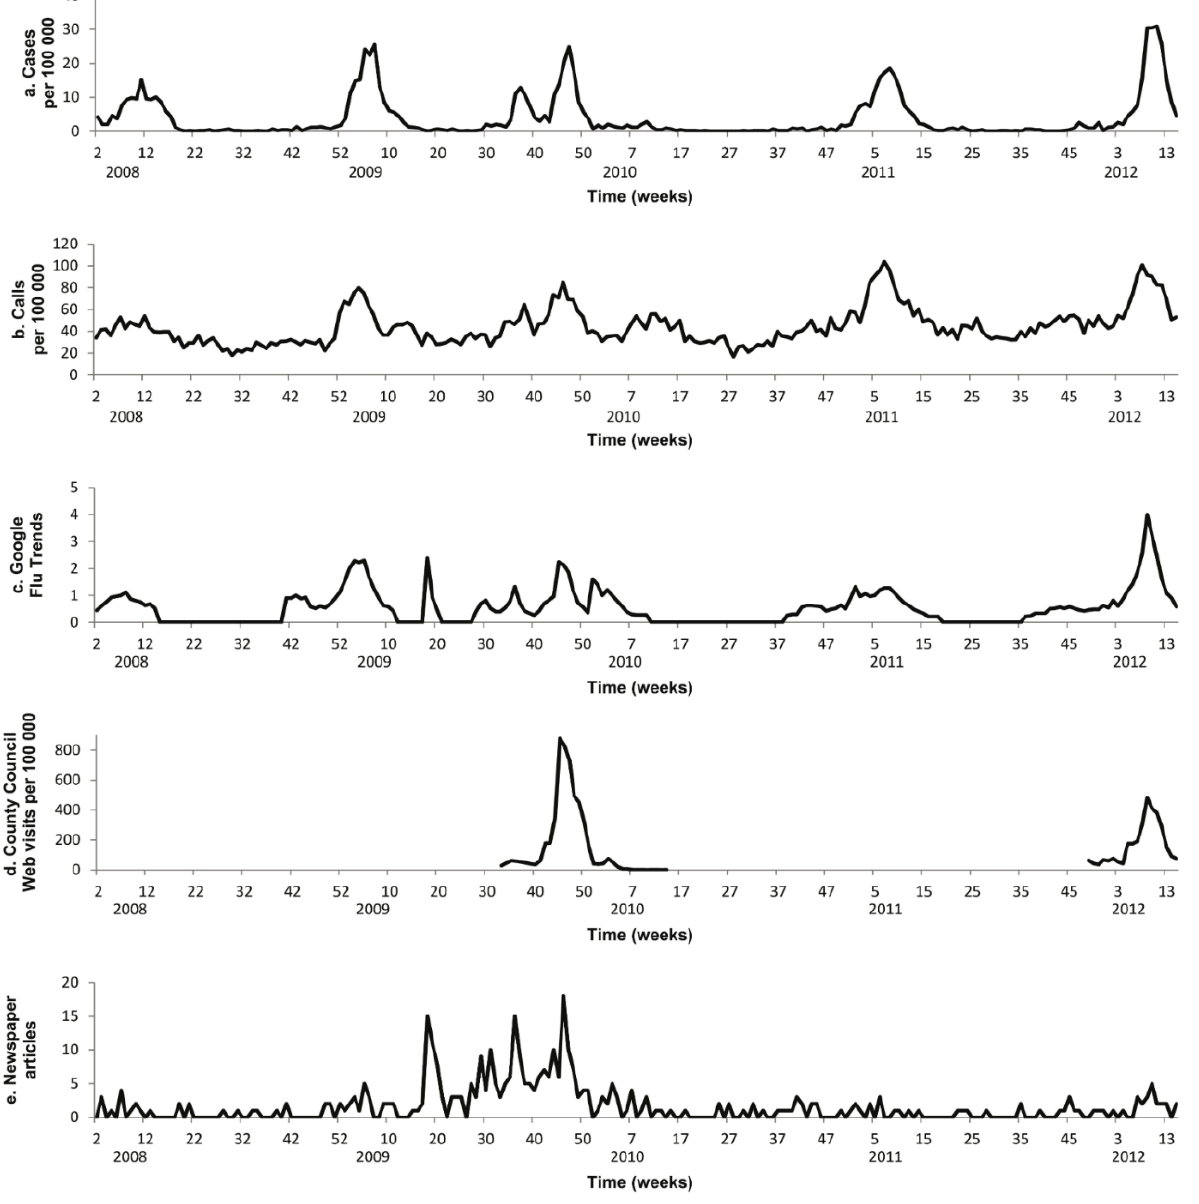
to r =.96 (95% CI .88-.99), P <.001, for the seasonal A H3N2 outbreak in 2008-2009 (Table 2). The time lag between GFT and influenza case data decreased from two weeks during the first outbreaks to one week from the 2009 A pH1N1 pandemic, with GFT data preceding influenza case